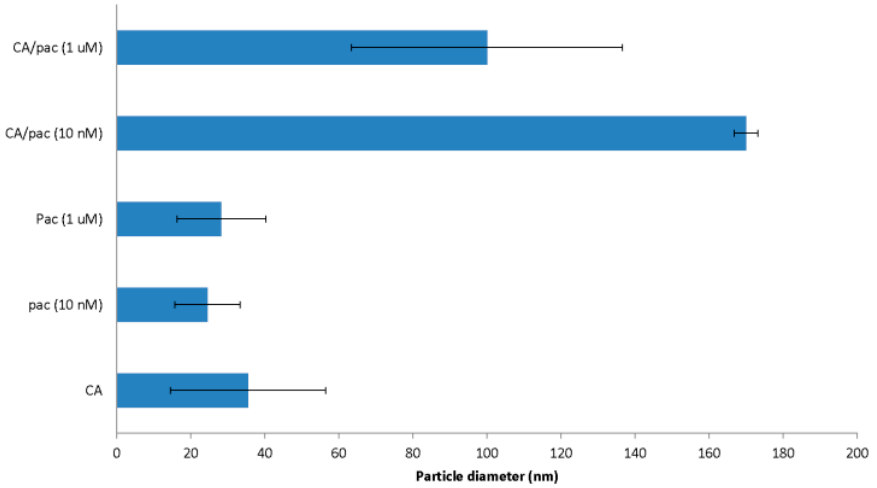
Figure 2. Size measurement for carbonate apatite particle complexes formulated by incorporation of 3 mM of CaCl 2 together with 10 nM and 1 μ M pac. The samples were then incubated at 37 °C for 30 min and also exposed to 10% FBS and maintained on ice prior to size measurement.